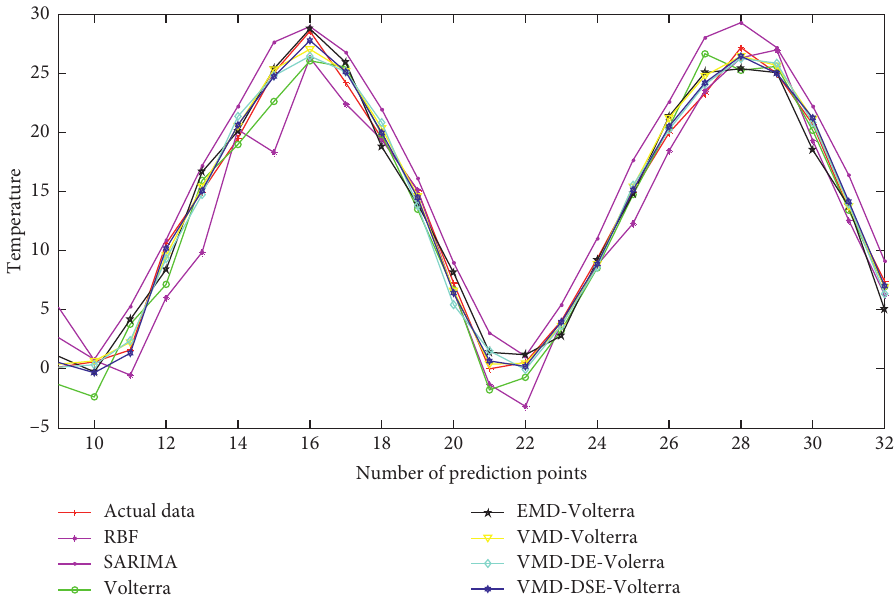
Figure 10: Local enlargement of prediction results for each model.